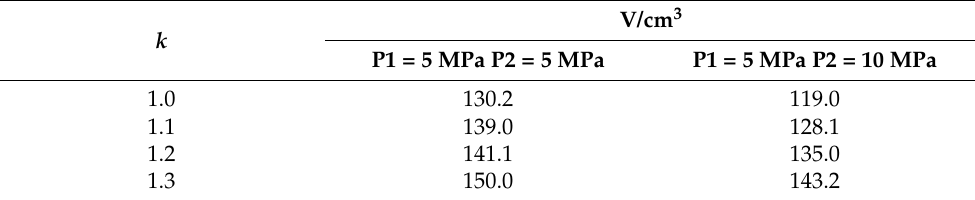
Figure 12. Y-direction elastic stress fields ( y Table 4. The crater volumes under different k